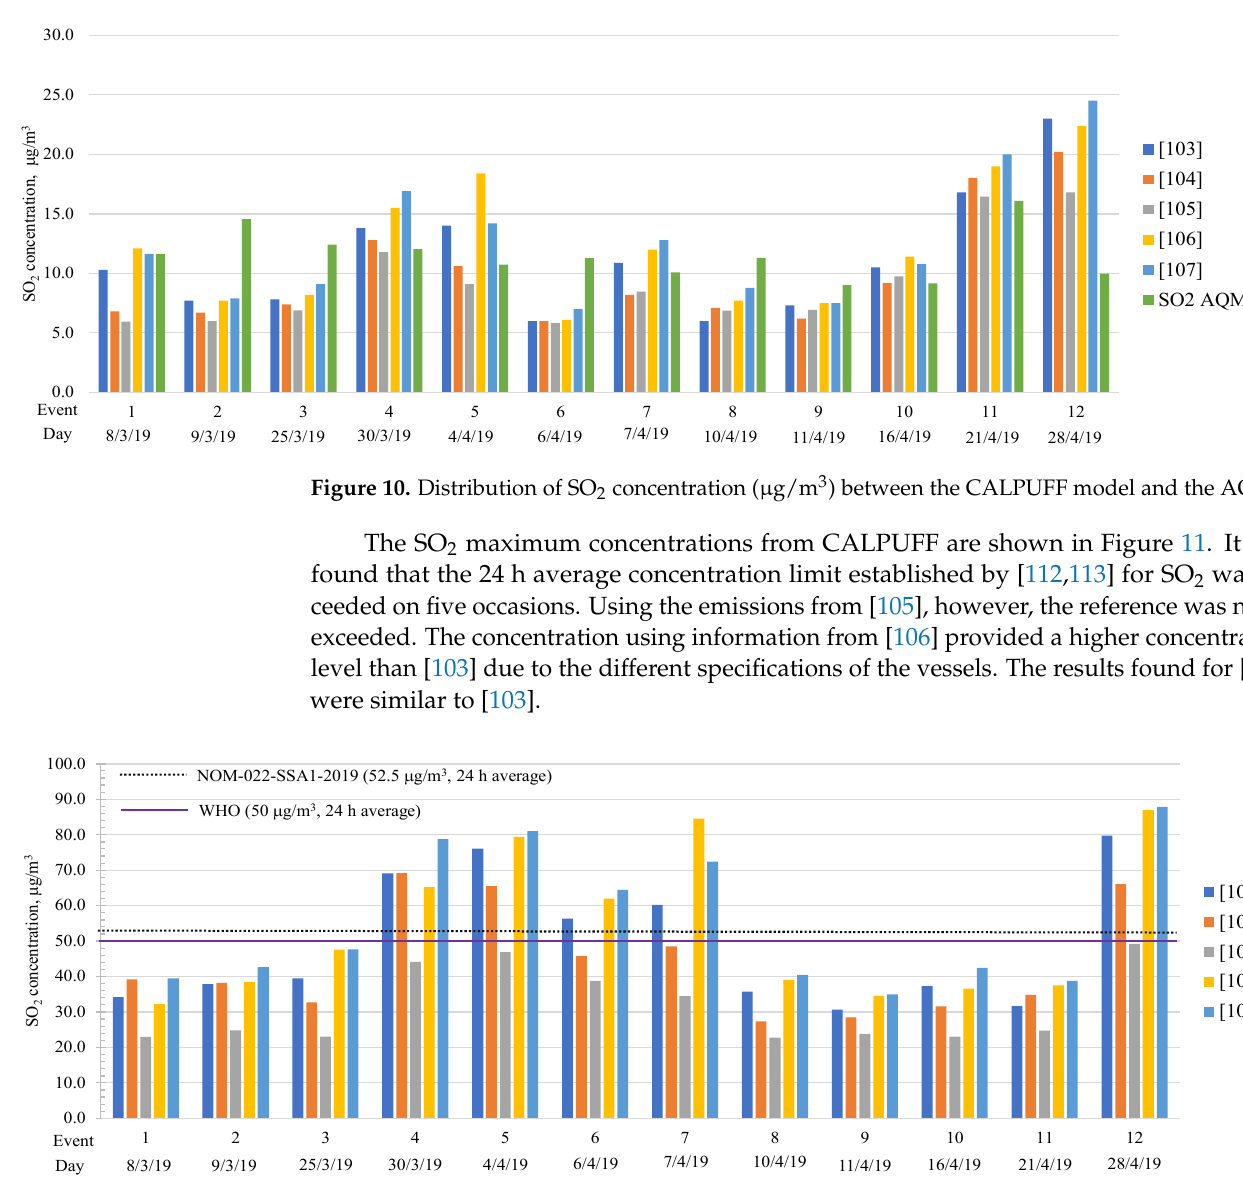
Figure 11. Maximum SO 2 concentration using the CALPUFF model. An example of the impact of port activities on air quality, according to the CALPUFF model, is shown in Figure 12 for day 4/28/19. On this day, the SO 2 concentration exceeded the 24 h standard average for (a) [103], (b) [104], (c) [106], and (d) [107]. It was found that the maximum concentration was 0.5 km from the emission source; thus, the greatest impact prevails inside the port area and affects the city of Veracruz, located SW of the port. Outside a 3 km radius of influence, the concentration is lower due to atmospheric dispersion, chemical destruction, and deposition.